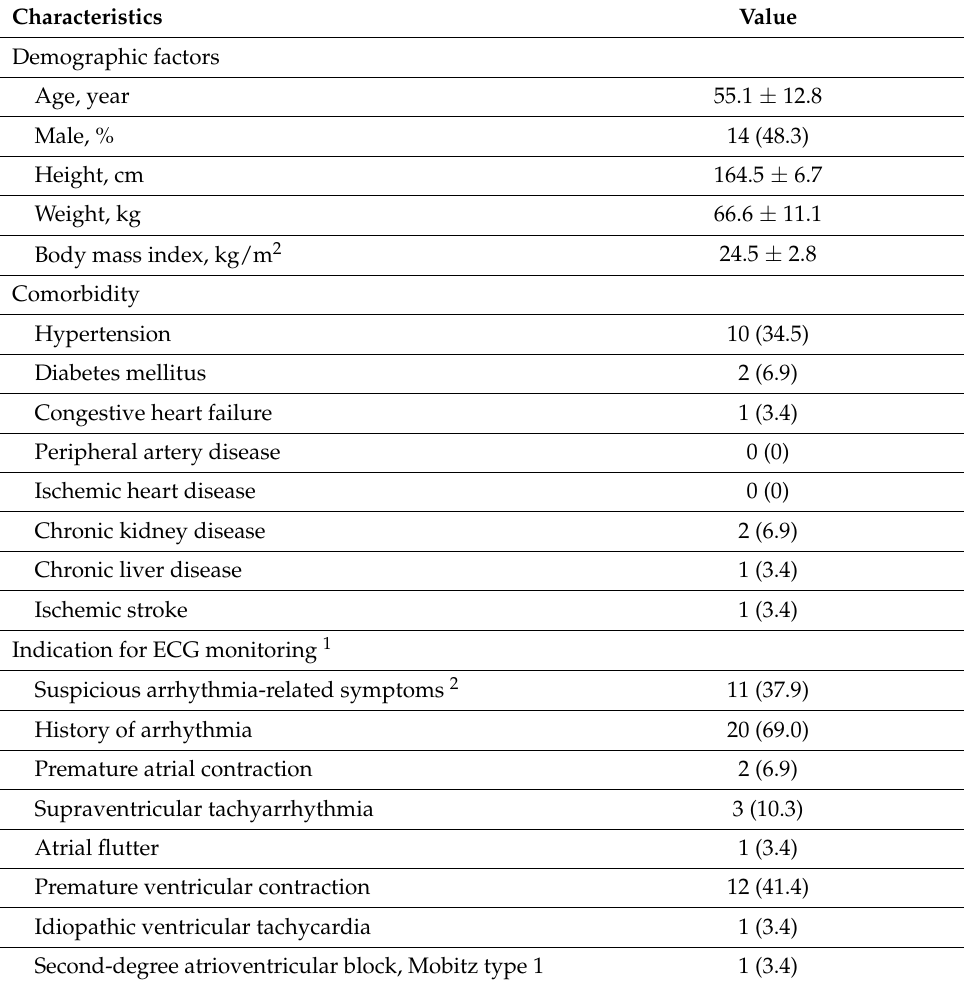
Table 2. Baseline characteristics of the study participants (total N =